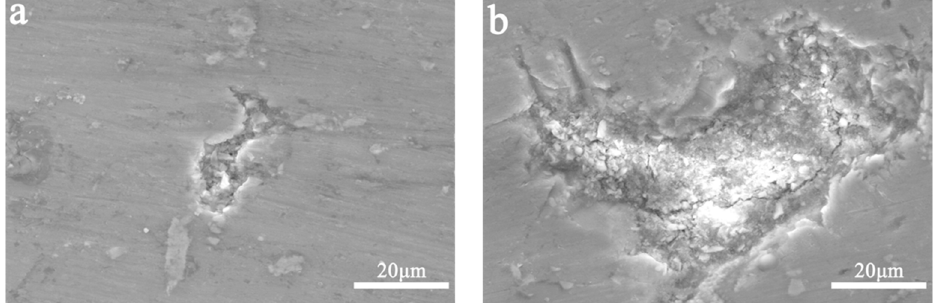
Figure 14. Corrosion pits of the alloy tested in 3.5% NaCl solution: ( a ) peak-age and ( b ) over-aged alloys.